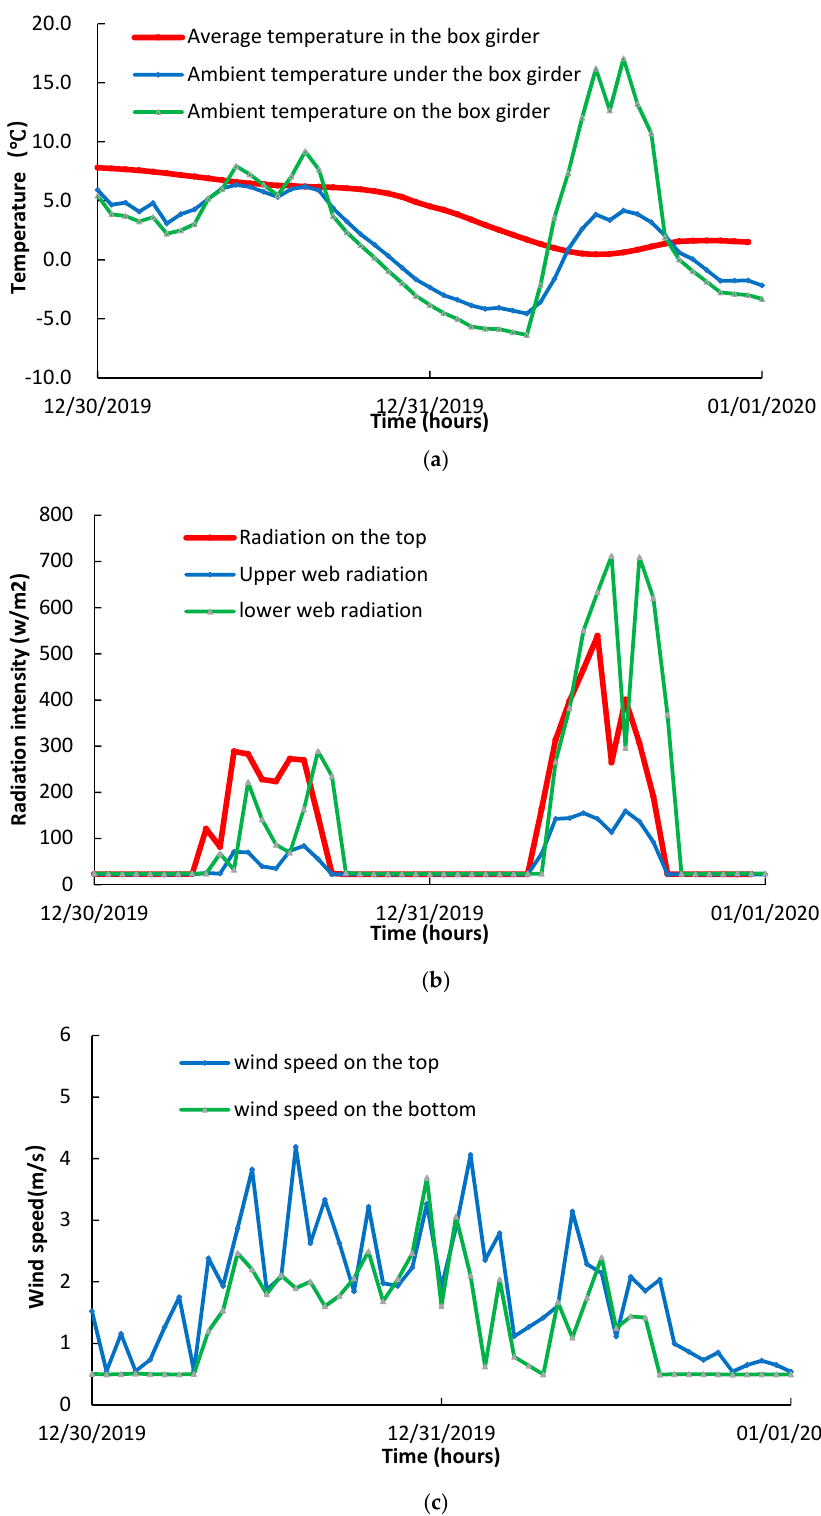
Figure 9. Variations on the boundaries of the box girder. ( a ) Temperature variations within and outside of the box girder; ( b ) solar radiation intensity variations on the top and web surface of the box girder on 30–31 December 2019; ( c ) wind speed variations on the top and web surface of the box girder on 30–31 December 2019.